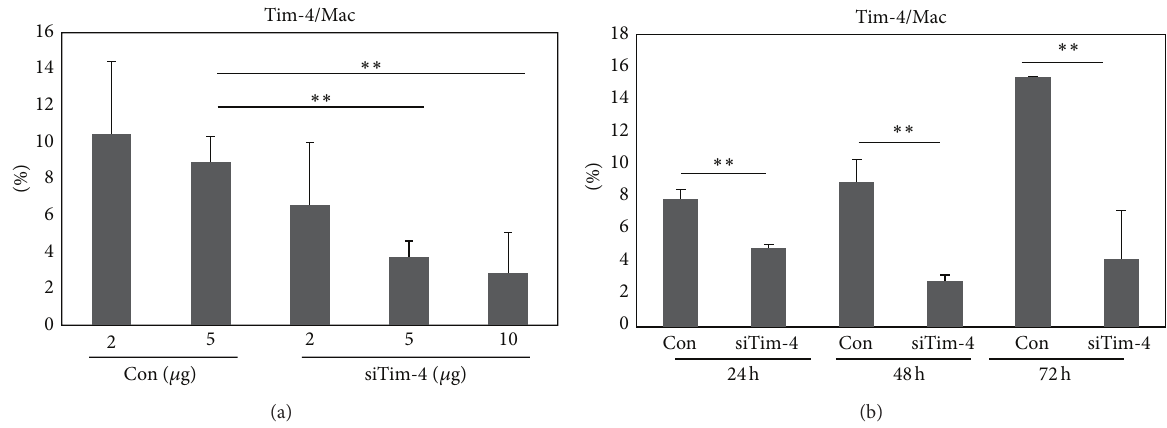
Figure 7: The expression of Tim-4 + cells was downregulated after siTim-4 treatment. Tim-4 siRNA was administered intraperitoneally and the frequencies of Tim-4 + cells were analyzed in peritoneal macrophages in normal (Nor) mice by FACS. (a) siTim-4 2, 5, and 10 𝜇 g/mouse or negative control siRNA (Con) (2 and 5 𝜇 g/mouse) were injected intraperitoneally into Nor mice. (b) Five 𝜇 g of siTim-4 was injected, and the frequencies of Tim-4 + peritoneal macrophages were analyzed 24, 48, and 72 hours later. Scrambled siRNA was used as the negative control ( 𝑛 = 3-4) ( ∗∗ 𝑃 < 0.05 ). Con: control siRNA injection into normal mice, siTim-4: Tim-4 siRNA injection to normal mice, Mac: peritoneal